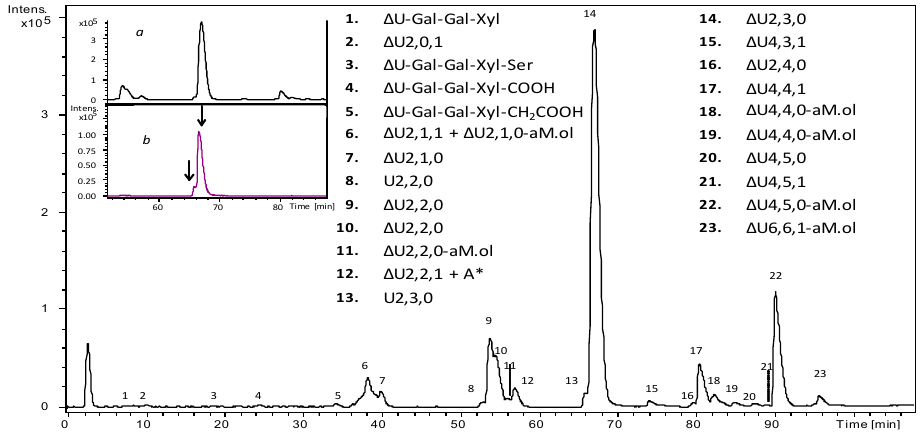
Figure 3. LC-MS profile (BPC) of a representative Fragmin ® sample (Frag-5) depolymerized by a cocktail of Heparinase I, II, III. Mass signals assignment of the main components is reported. Inset : expansion of chromatogram portion with the main unsaturated trisulfated disaccharide ( ∆ U 2S -A NS,6S ) eluted (panel a); extracted ion chromatograms (EIC) of m / z 594.0 attributed to saturated trisulfated disaccharide (panel b): as indicated by arrows, two positional isomers were detected. LC elution conditions: isocratic step at 2% B for 10 min, followed by a linear gradient to 60% B in 90 min and final steps of column washing and reconditioning.